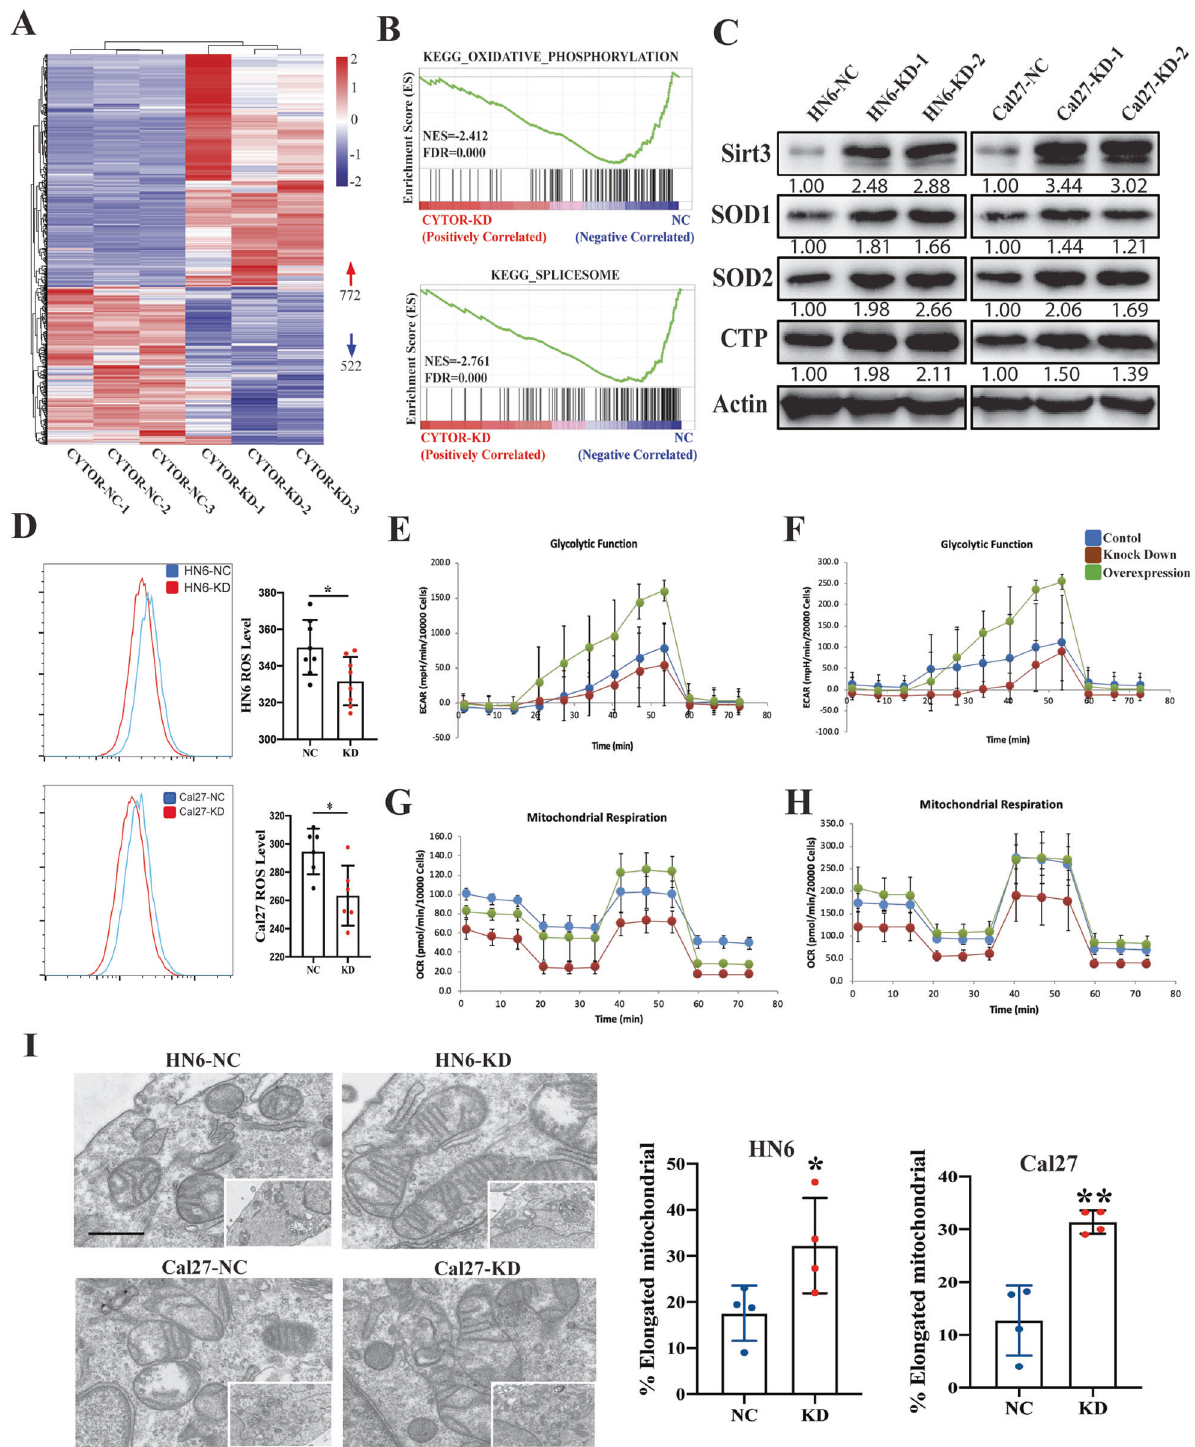
Fig. 2 CYTOR regulates the glycolysis and mitochondrial respiration function in oral cancer cells. A RNA-seq analysis showing that CYTOR expression is associated with 1294 genes dysregulation in Cal27 cells. B Gene set enrichment analysis (GSEA) of the CYTOR-related pathways in CYTOR-knockdown Cal27 cells. C Western blot analysis showing the mitochondrial-related proteins (SIRT3, CTP, SOD1, SOD2) expression in CYTOR- depletion cells. D Flow cytometry analysis of ROS level (MitoSOX) in HN6 and Cal27 cells. E , F CYTOR-knockdown and CYTOR-overexpression HN6 and Cal27 cells were detected for ECAR to indicate the glycolysis stress. Median values are plotted in the column with data generated from six technical replicates and three biological replicates (each dot indicates the mean value of three independent biological replicates), statistical analysis was performed by unpaired t -tests. G , H CYTOR-knockdown and CYTOR-overexpression HN6 and Cal27 cells were detected for OCR to indicate the mitochondrial respiration. I Transmission electron microscope exposing the ultrastructure of mitochondrial in HN6 and Cal27 cells. Median values are plotted in the dots plot with data generated from four independent biological replicates, statistical analysis was performed by unpaired t -tests (KD knockdown, NC negative control; scale bar = 1 μ m. The data was presented as mean ±SD, * P <0.05). Cell Death and Disease (2022)